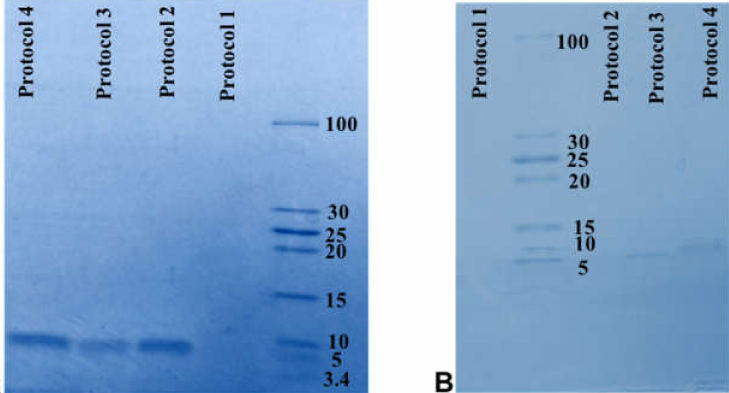
Figure 4. SDS-PAGE performed on the pellets and supernatants. ( A ) SDS-PAGE on the supernatant